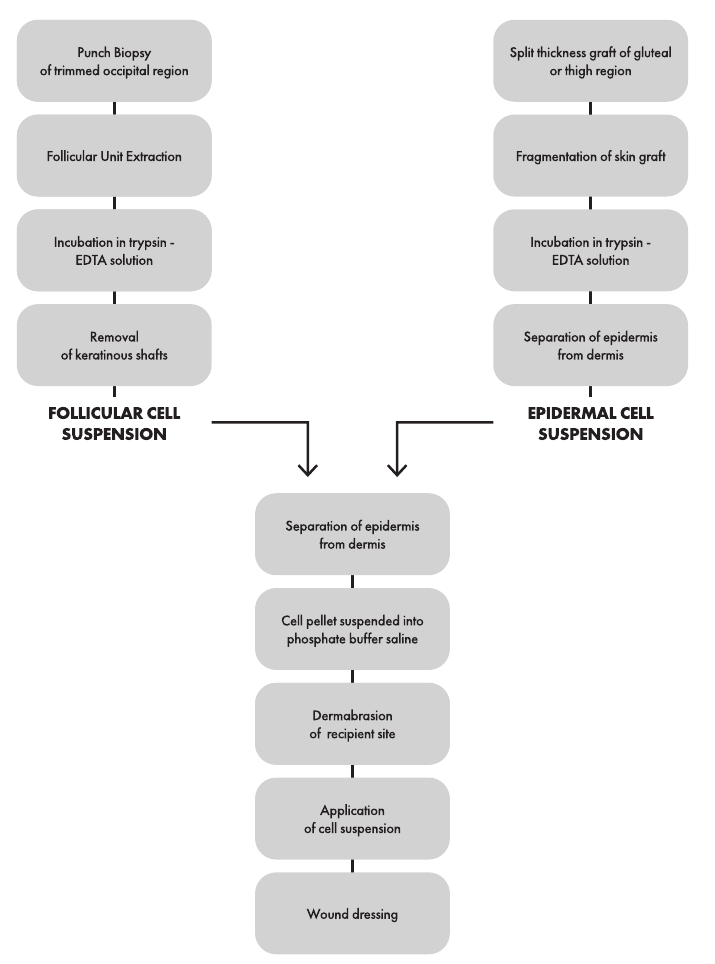
Figure 3. Course of cellular